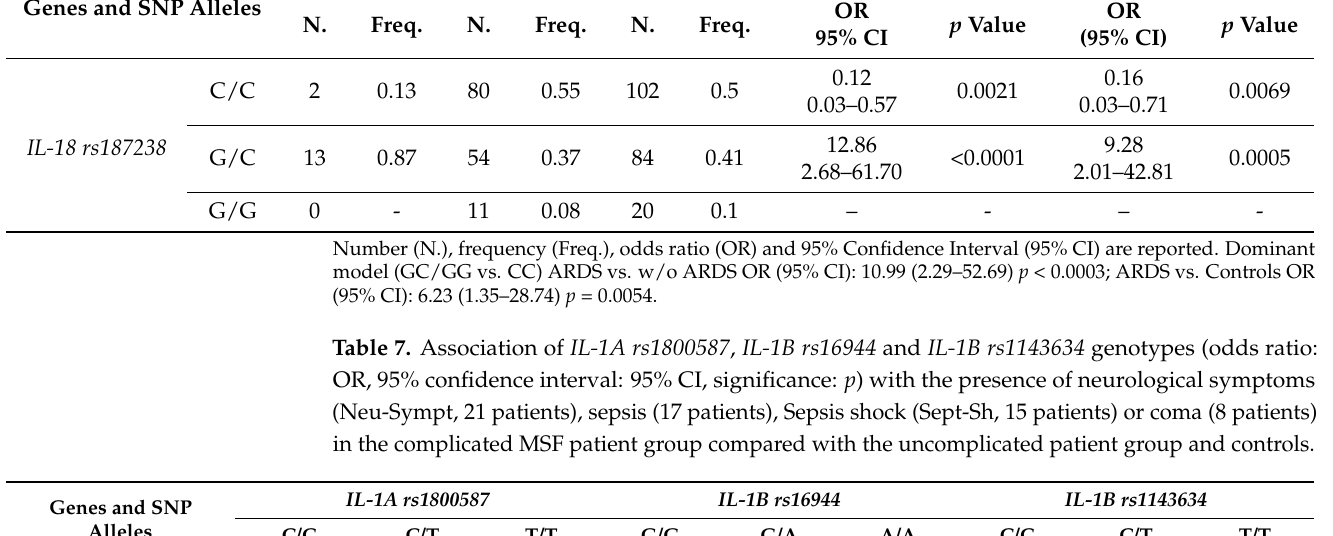
MSF. On the other hand, our results, obtained on 15 MSF patients affected by ARDS, do not